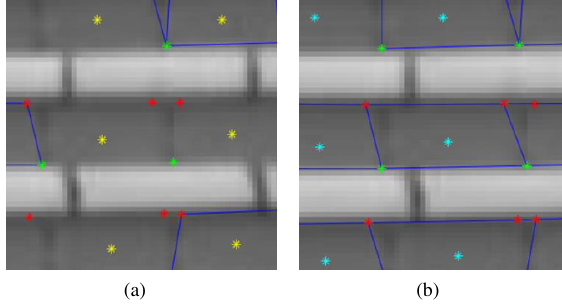
Figure 4. Iterative process case 2: a) two corners have been de- tected and two Förstner points exist as possible corners. Possible centre points marked in yellow. b) newly added rectangle with two existing and two new corner points with verified centre point (blue).